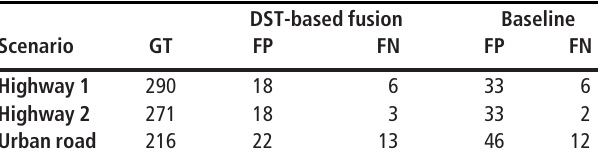
Table I Aggregate results of two approaches in highway and